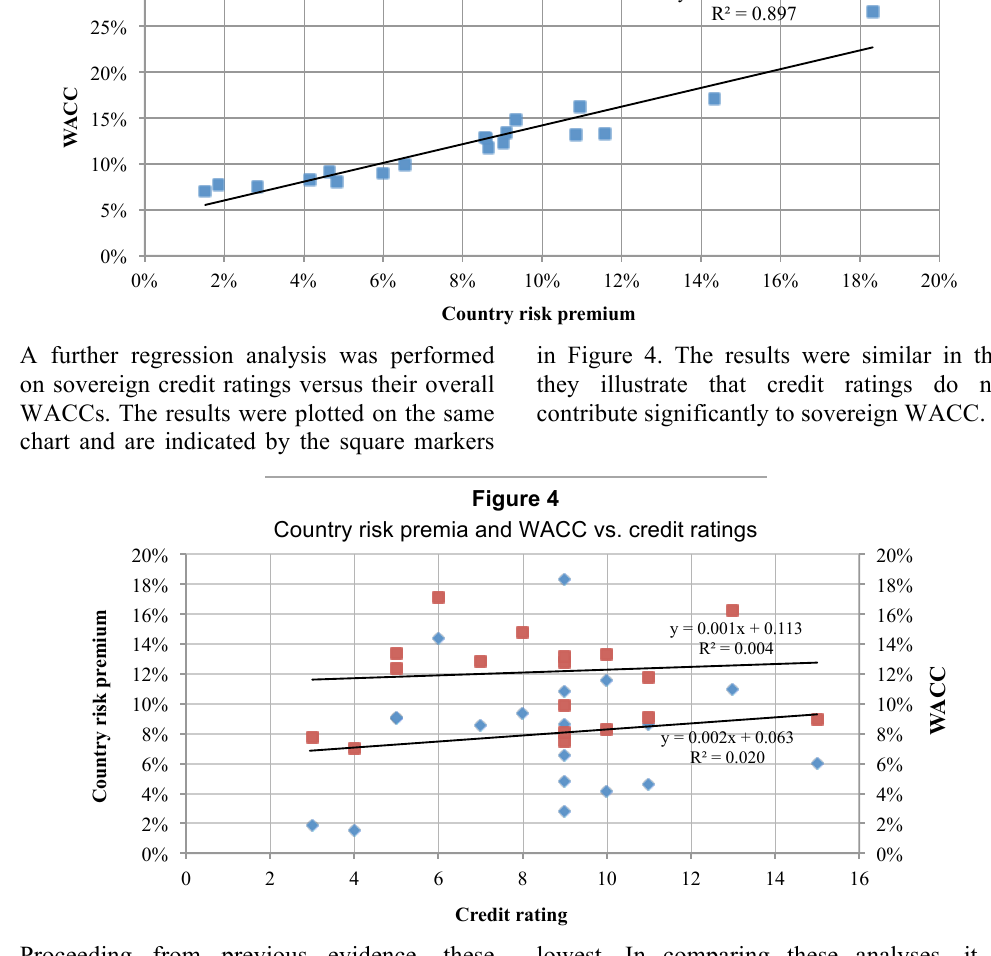
Country risk premia vs. WACC